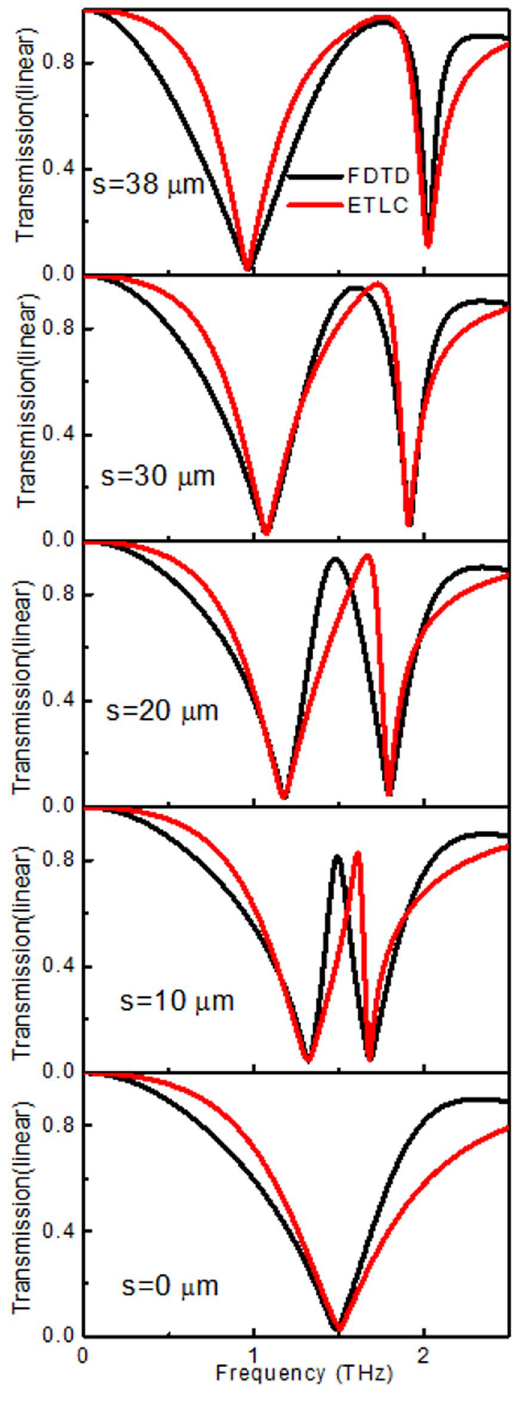
Figure 7. Comparison of transmission simulated by FITD methods (black line) and calculated by ECTL (red line) of different s varied from 0 to 38 μ